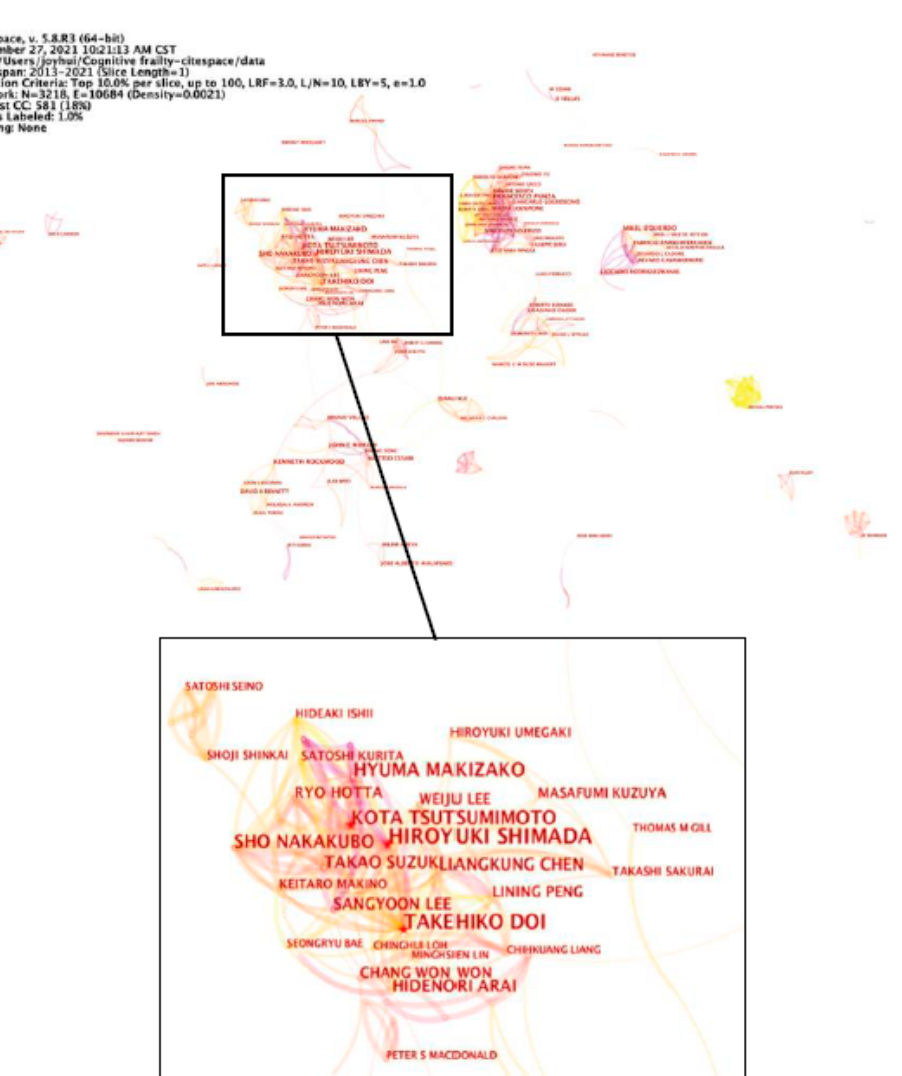
Figure 4. Collaboration network of authors. Shimada H., Doi T., and Tsutsumimoto K. were the three most prolific authors of cognitive frailty